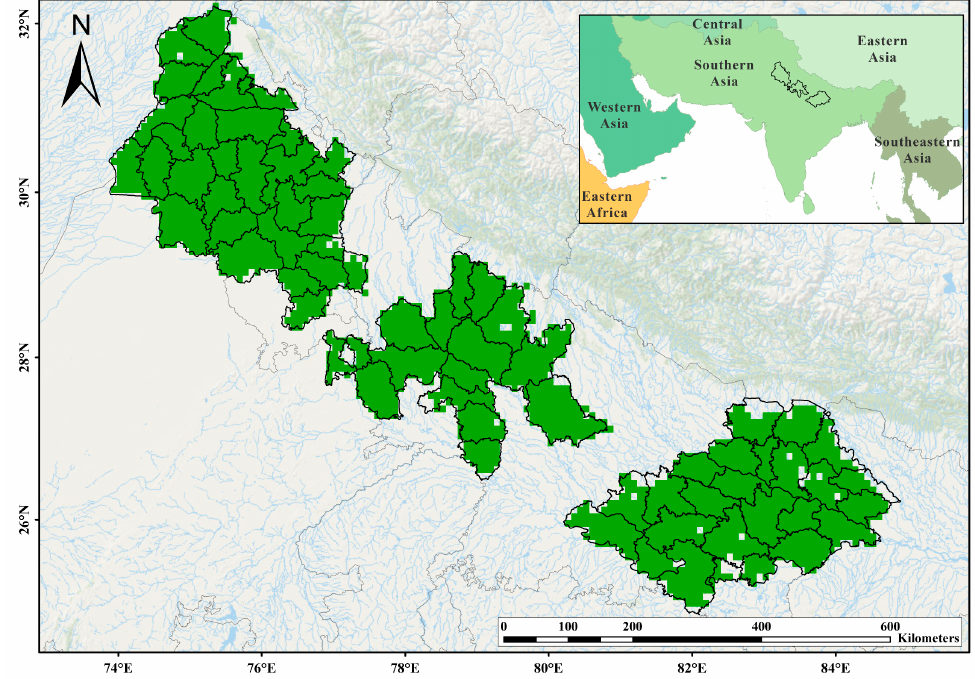
Figure 1. The study area in the Indo-Gangetic Plains (IGP) of India. Green pixels indicate grid cells with more than 40% wheat. The base map at the top-right corner is that of commonly recognized world regions.